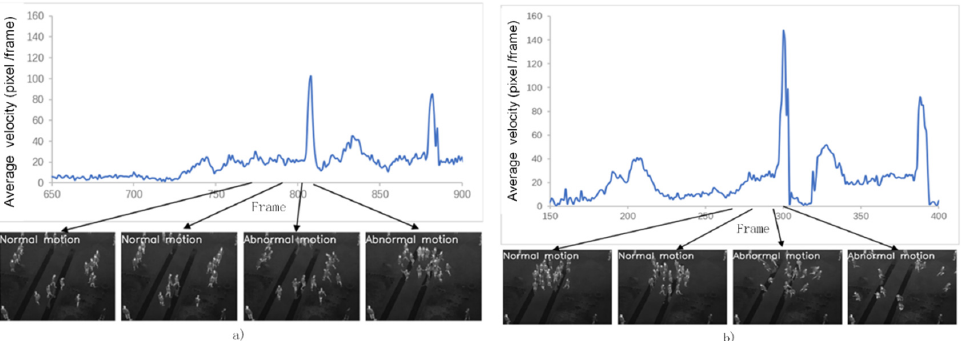
Figure 10. Crowd behavior recognition. ( a ) Crowd-aggregating motion detection, ( b ) crowd-escaping motion detection.